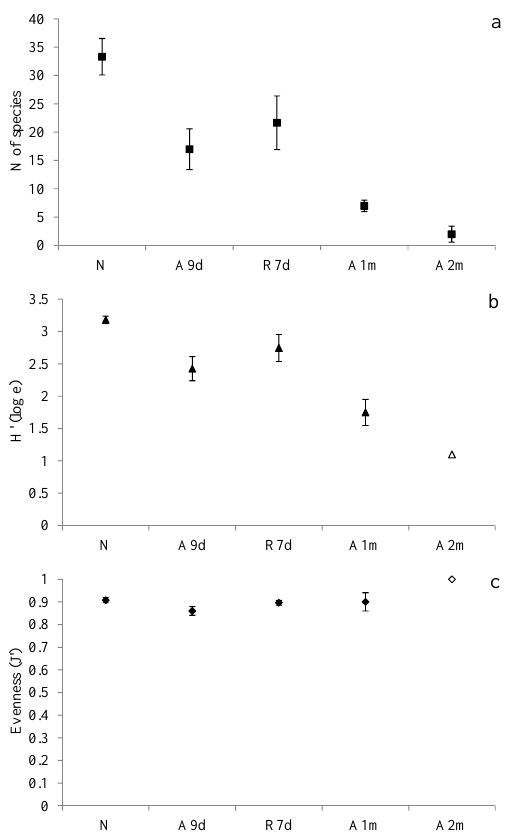
Stylicletodes sp. 2